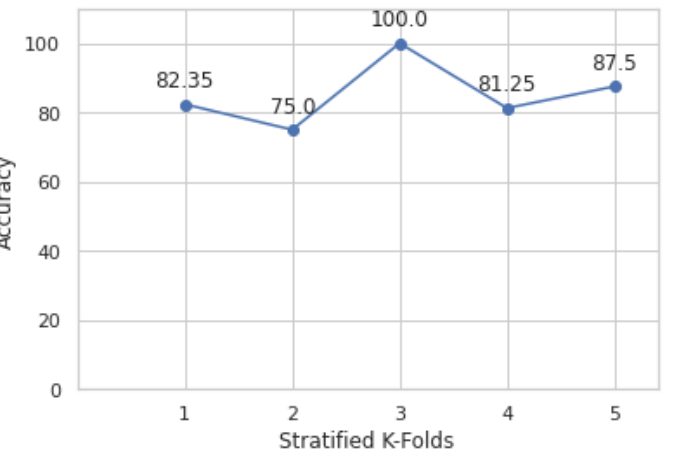
Figure 8. The classification accuracies of the SVM model using the stratified five-fold cross-validation. The classification accuracy of the SVM model using stratified ten-fold cross-validation is shown in Figure 9. It demonstrates that the accuracy of fold-6 is the highest. This model was then discovered to support stratified 10-fold cross-validation with a mean accuracy of 85.14% and an SD of 0.0940. Using stratified 10-fold cross-validation, the optimal Hyperparameter values were kernel = rbf, gamma = 0.1, and C =